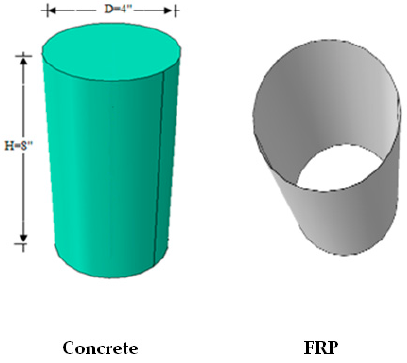
Figure 3. 3-D strengthened concrete column model.